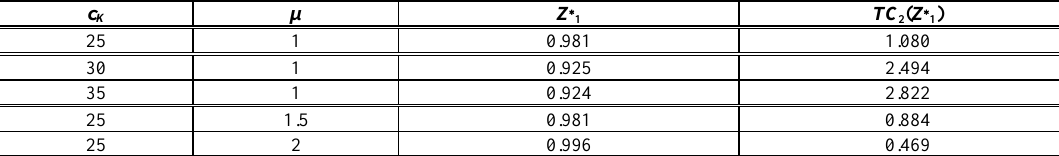
Table 2. Optimal Z ∗ 1 and TC 2 ( Z ∗ 1 ) of Model 2 for K =25, 30, 35 and 𝜇 = 1, 1.5, 2 when T = 1.